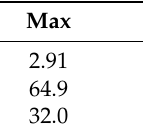
Table 3. Total training time in